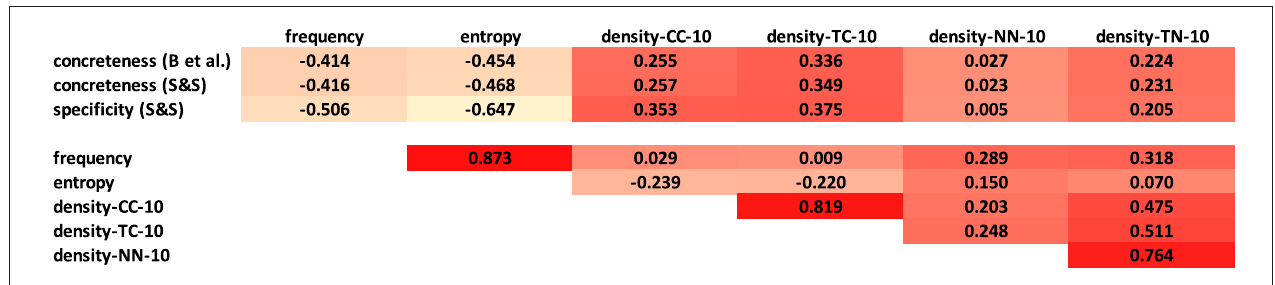
Frontiers in Artificial Intelligence |